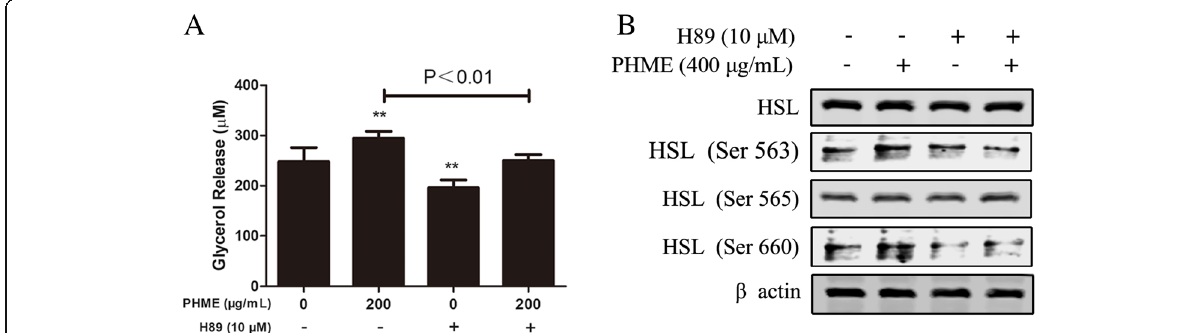
Fig. 4 Effects of a PKA inhibitor (H89) on PHME-stimulated lipolysis. a Fully differentiated 3T3-L1 adipocytes were treated with 200 μ g/mL PHME alone or in the presence of 10 μ M H89 for 12 h, then glycerol released into the medium was quantified. b Fully differentiated 3T3-L1 adipocytes were treated with 400 μ g/mL PHME alone or in the presence of 10 μ M H89 for 12 h, then cells were lysed, and then basal and phosphorylated levels of HSL were measured using western blotting analysis. Values are expressed as mean ± SD ( n = 4), ** P < 0.01 vs. control